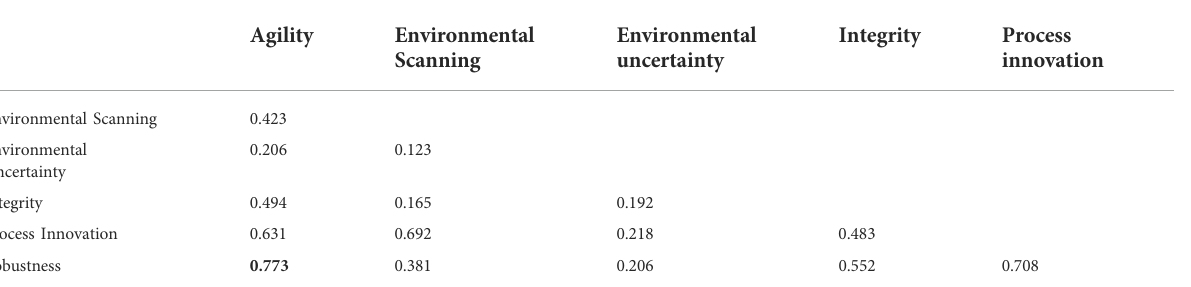
TABLE 5 Heterotrait-Monotrait Ratio